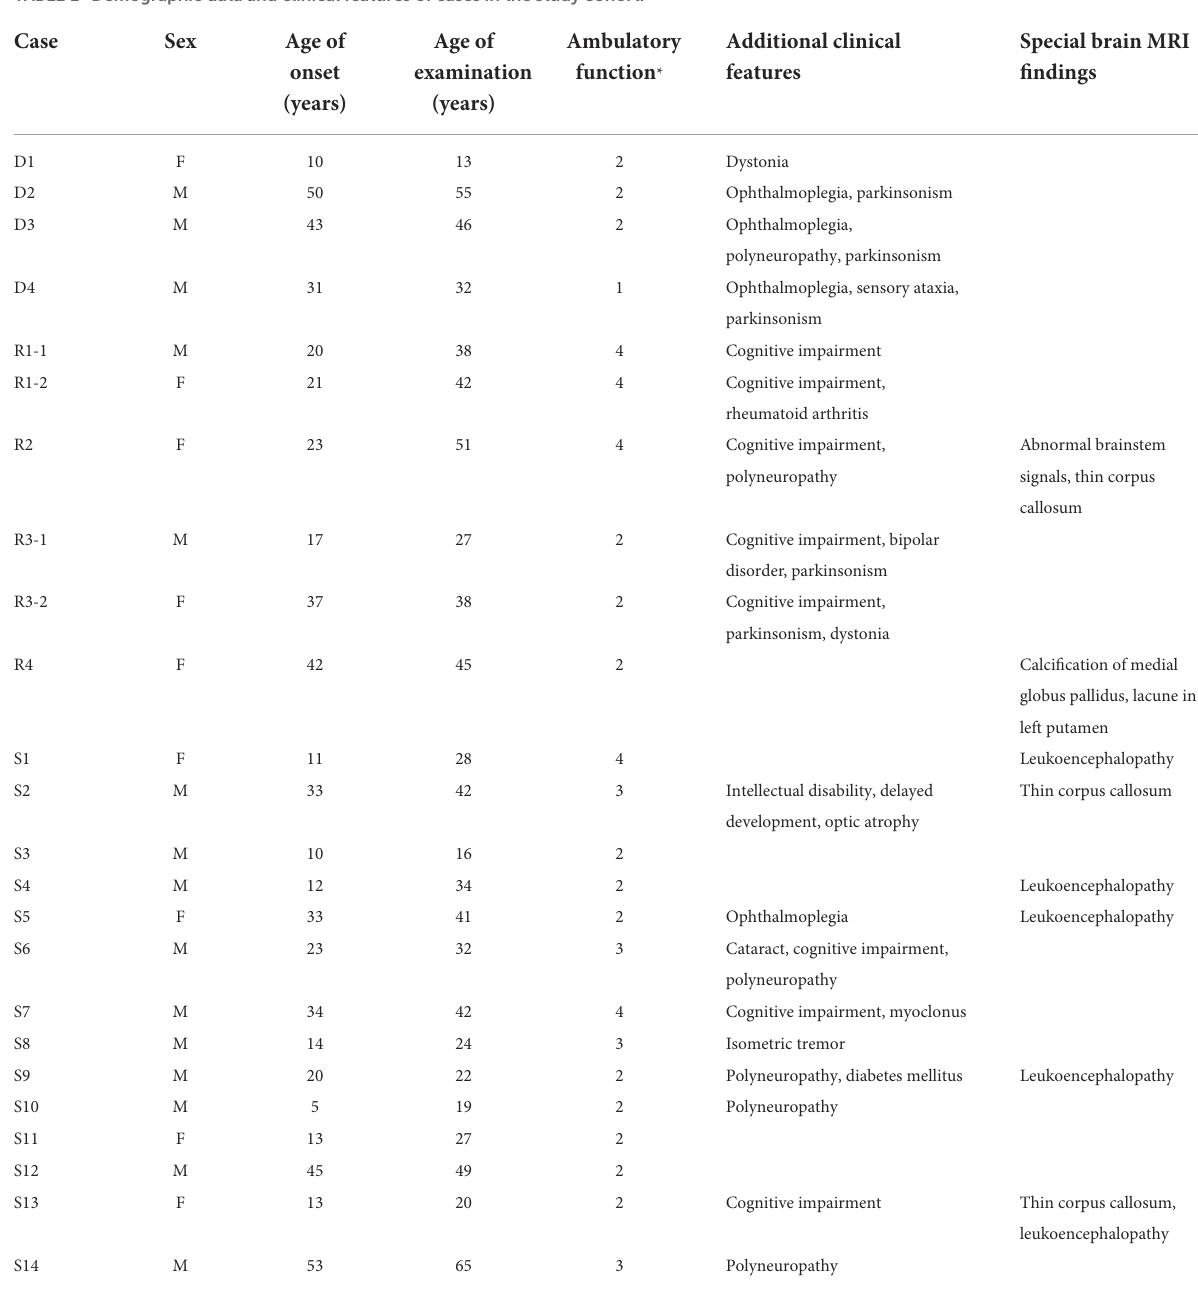
TABLE 1 Demographic data and clinical features of cases in the study